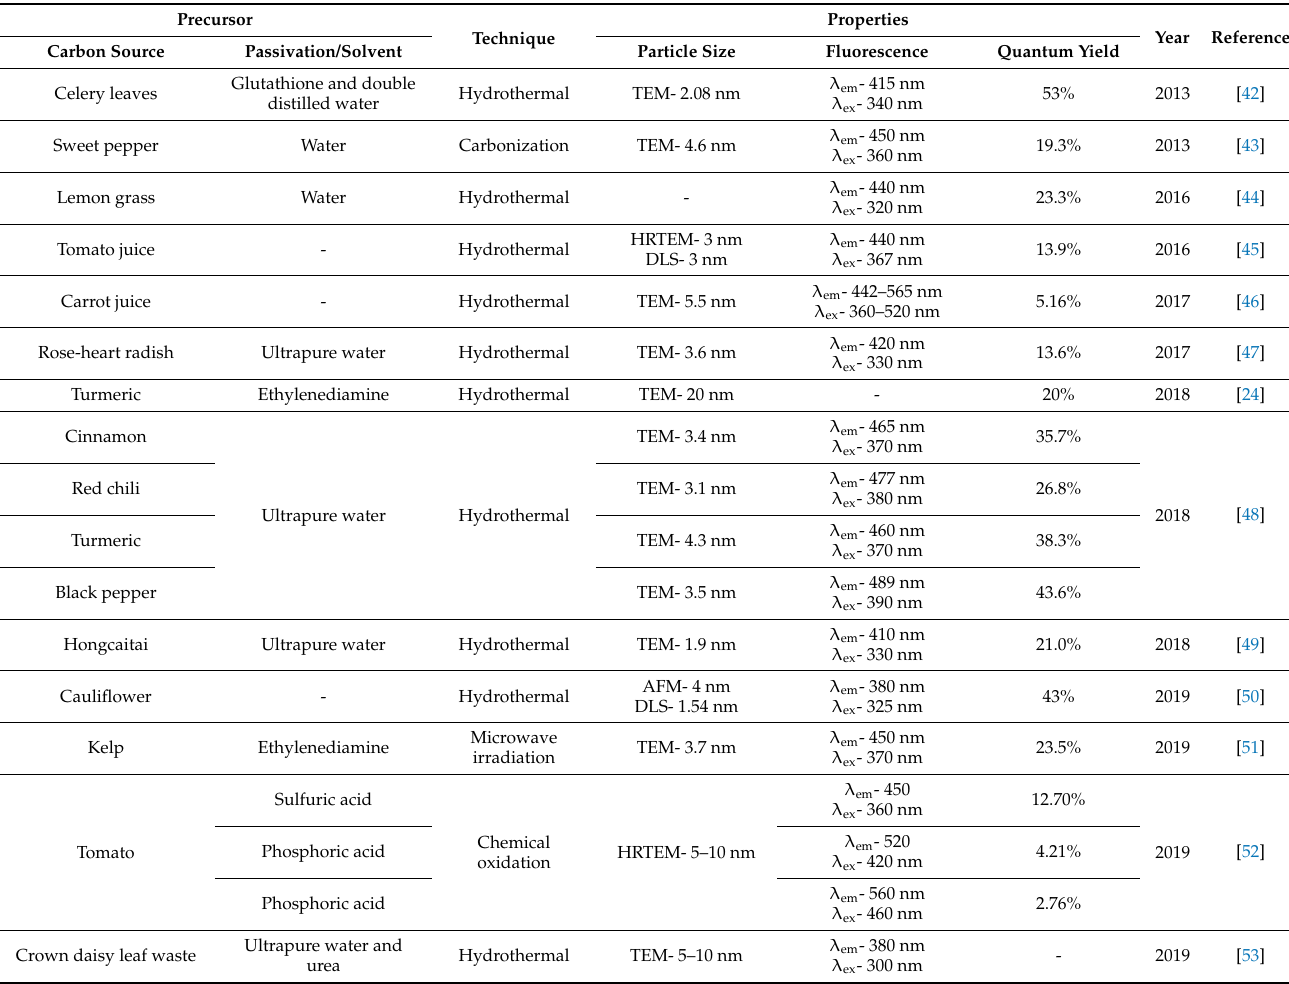
Table 2. Summary of the synthesis of CDs from